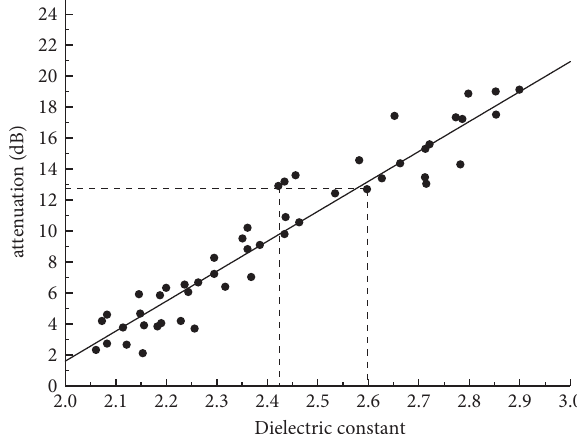
Figure 2: Reference diagram for the phase ambiguity correction algorithm. Te dielectric range example is indicated with dashed